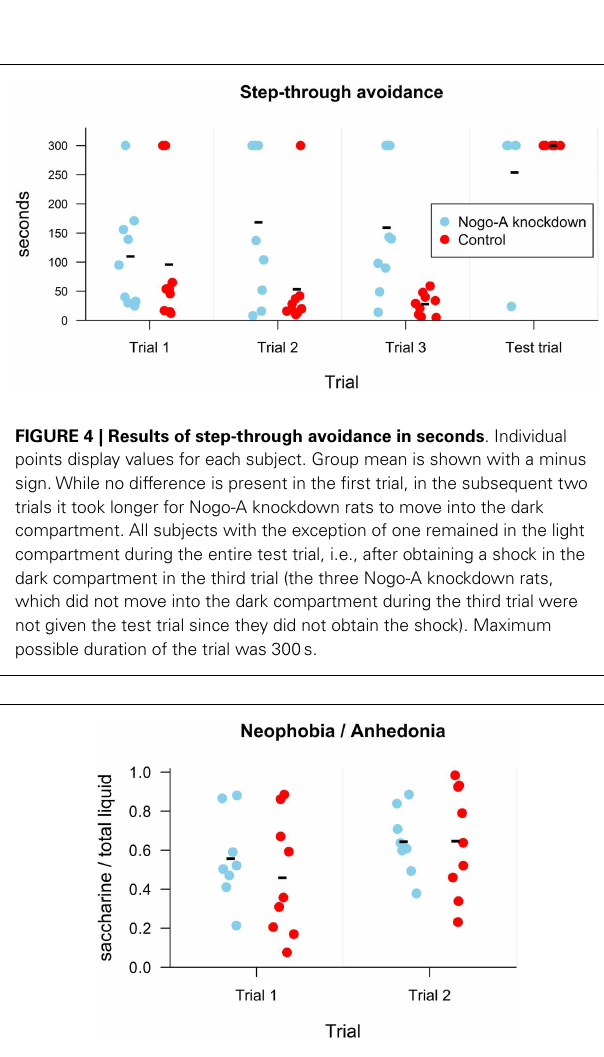
FIGURE 5 | Results of the neophobia/anhedonia task as a ratio of consumed saccharine to total consumed liquid . Individual points display values for each subject. Group mean is shown with a minus sign. No difference is seen between groups (blue – Nogo-A knockdown, red – control) in either